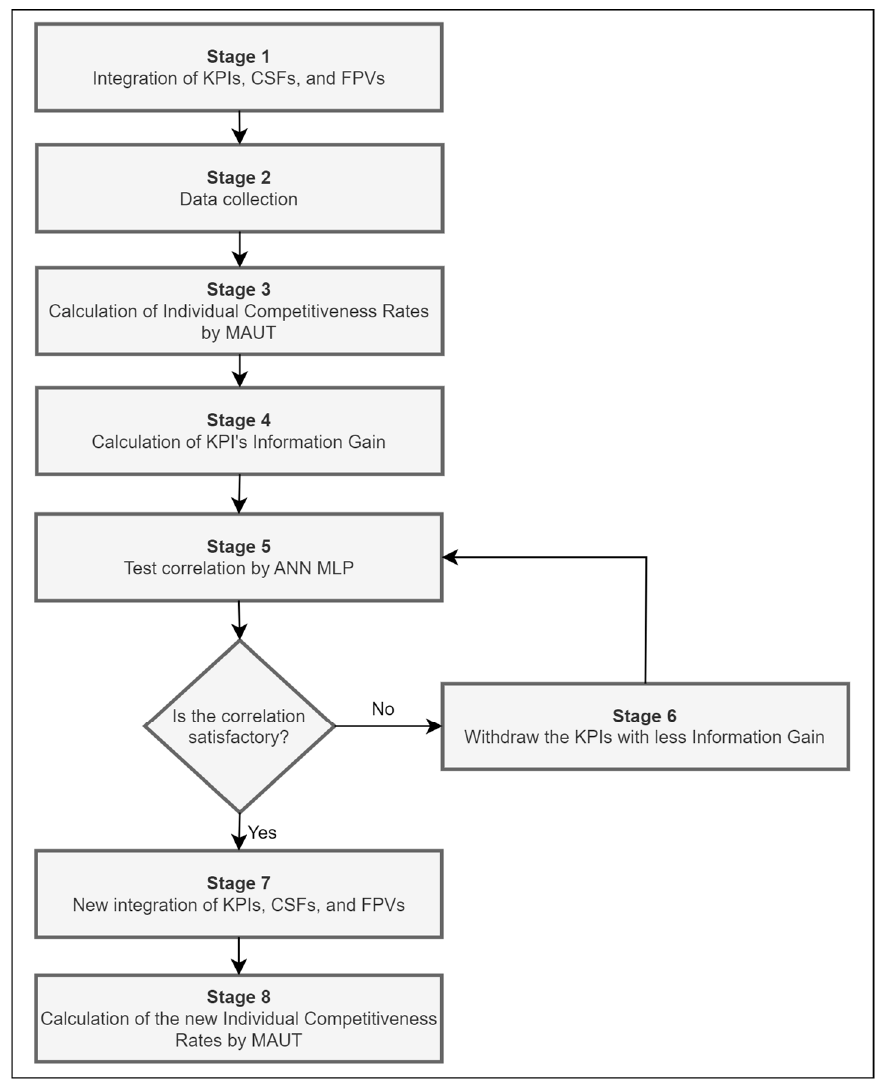
Figure 1. GIANN method stages.